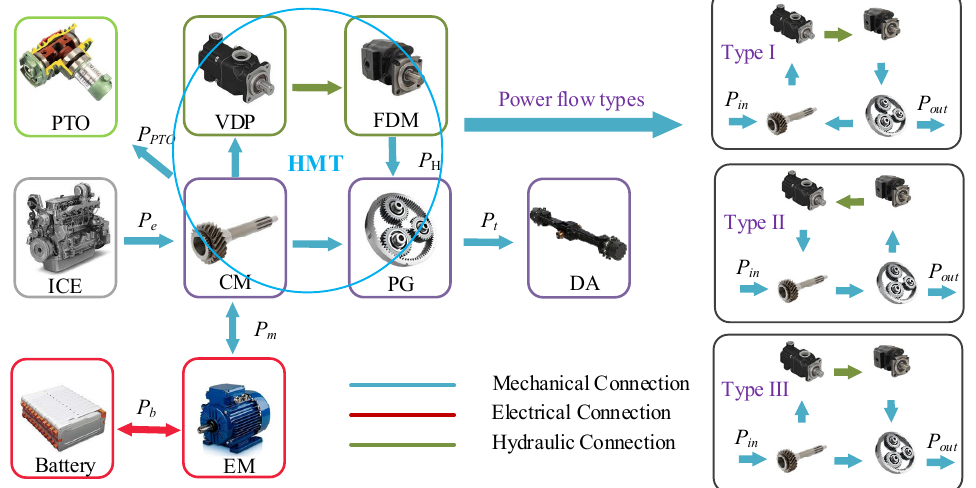
Figure 6. Power flow of powertrain system. (CM: coupling mechanism; ICE: internal combustion engine; VDP: variable displacement pump; FDM: fixed displacement motor; DA: drive axle; P PTO : power take-off power; P H : hydraulic system power; P t : traction power.). According to Figure 6: in type I power flow, the power of the hydraulic path is greater than the input power, and the HMT efficiency of this transmission mode is low because a large amount of power is transmitted through the inefficient hydraulic path; in type II power flow, the power of the hydraulic path is transmitted in the reverse direction, result- ing in an increased power of the mechanical path, and the HMT efficiency of this mode is higher than type I and lower than type III; in type III power flow, the power is divided into hydraulic and mechanical paths and then merged, the power of both paths is trans- mitted in the positive direction, and the HMT efficiency in this mode is the highest.